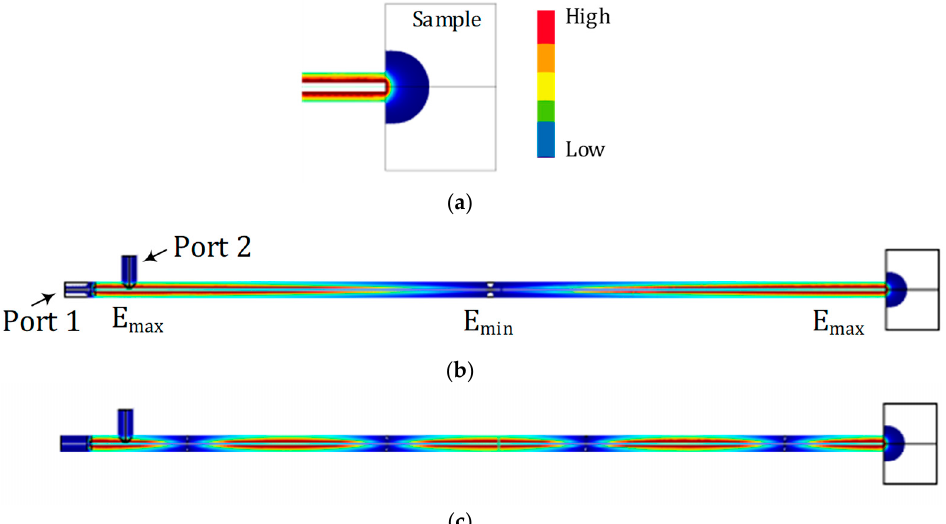
Figure 3. Full 3D simulation results modeled by using COMSOL Multiphysics. E-field distribution within the resonator and fringing field inside the sample is plotted ( a ) at 350 MHz ( N = 1) zoomed in to show the probe-sample boundary, ( b ) at 350 MHz ( N = 1), and ( c ) at 1400 MHz ( N = 4).